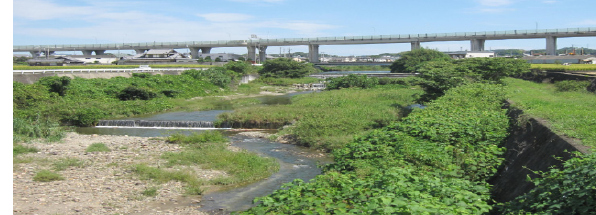
Figure 3. Phantom3 Professional